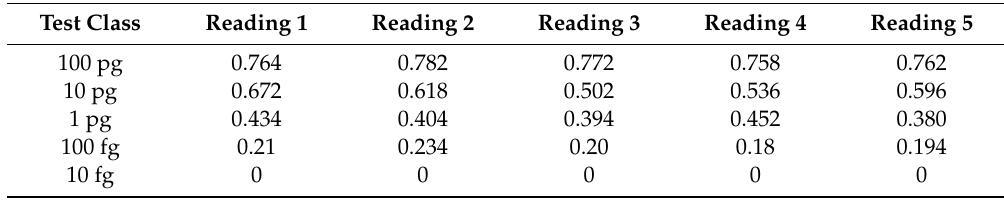
Table 1. Calculated T/C ratio for LFA set #1.